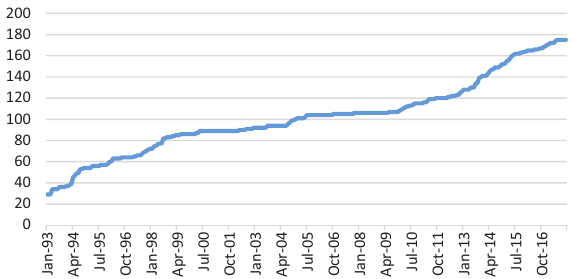
Figure 1. Monthly variation in REIT number from